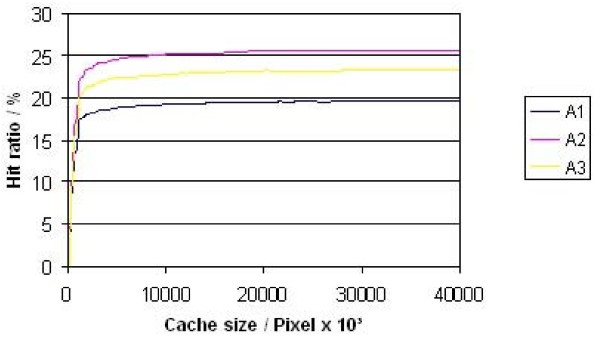
Cache hit ratio.